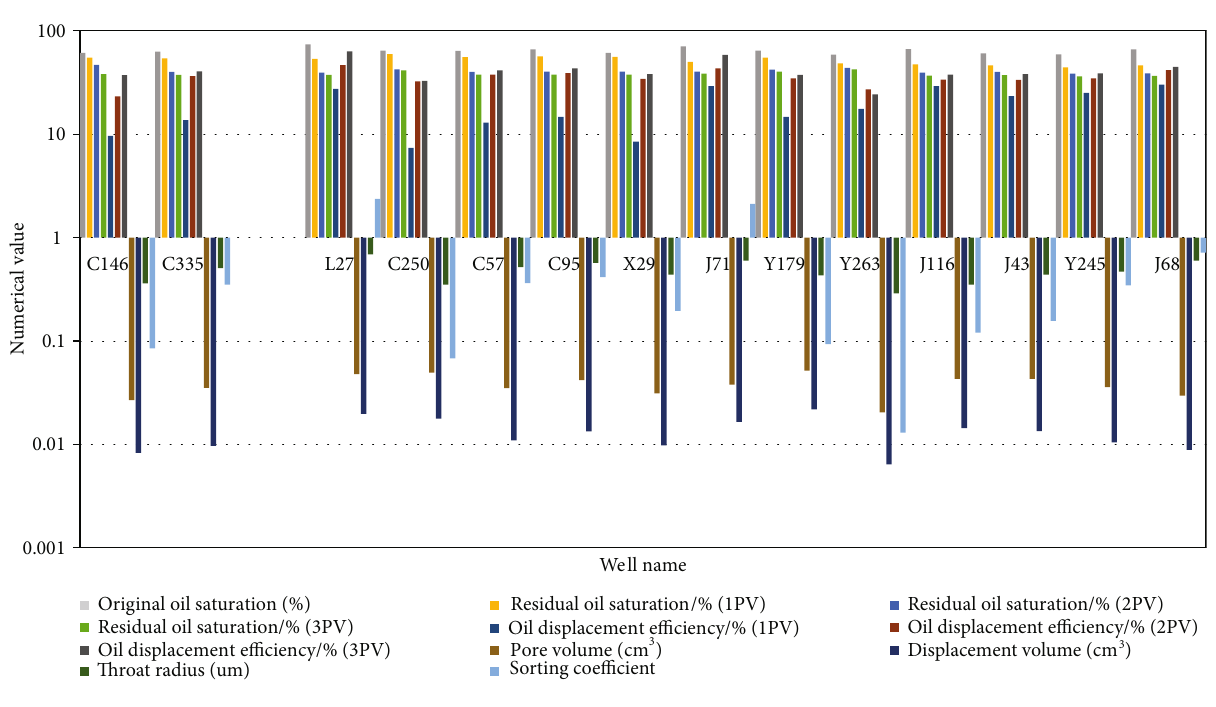
Figure 4: Characteristics of water fl